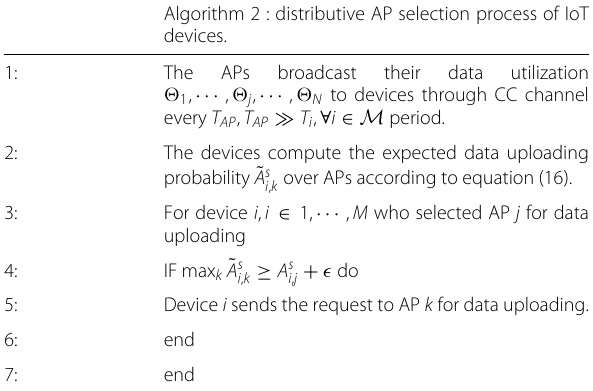
Table 1 AP selection process of IoT devices Algorithm 2 : distributive AP selection process of IoT